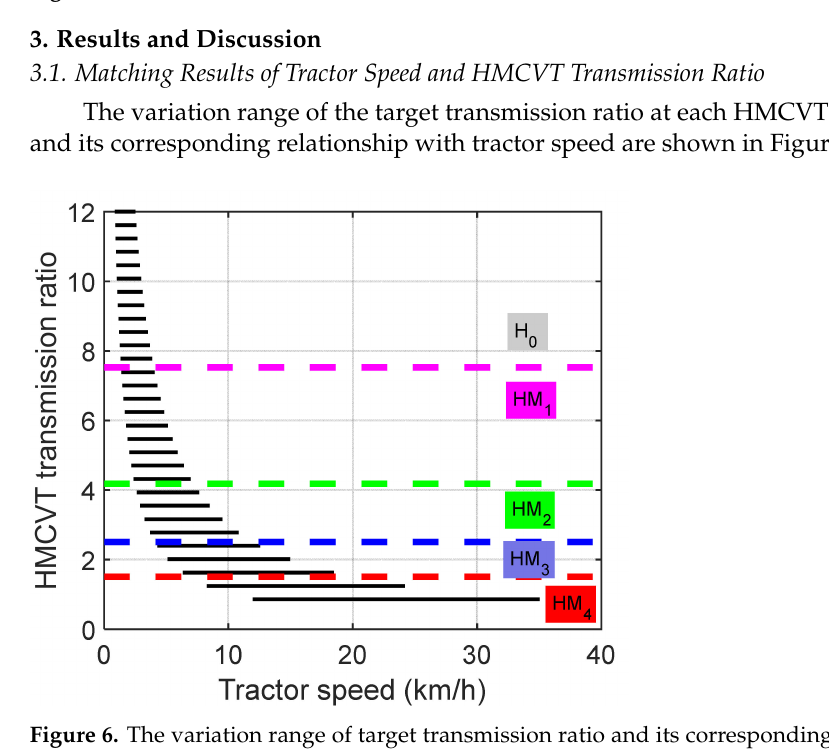
Figure 5. The simulation model of an HMCVT based on Simulation X.